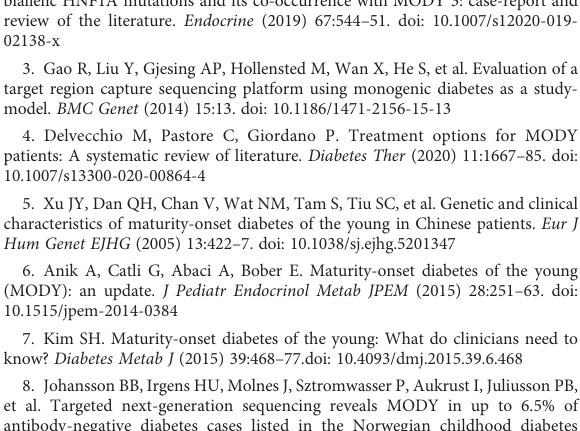
SUPPLEMENTARY TABLE 3 Evolutionary conservation analysis for the three mutations in ABCC8. NP_001274103.1 match to NM_001287174.3; Proban (A) ABCC8 :NM_001287174:exon10:c.C1555T:p.R519C; Proban (B) ABCC8